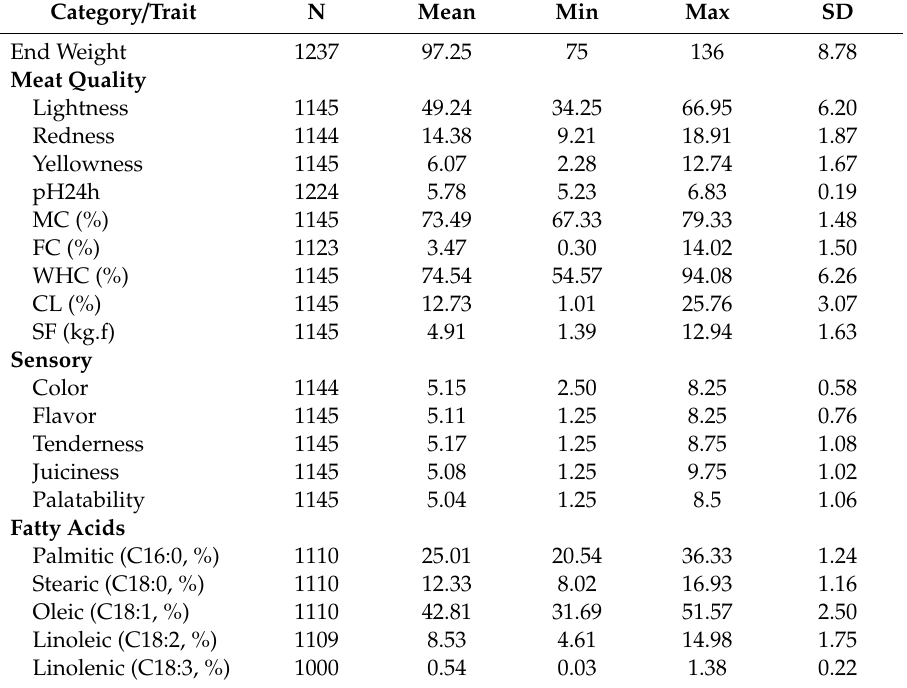
Table 1. Descriptive statistics for meat quality, sensory characteristics, and fatty-acid composition of Duroc